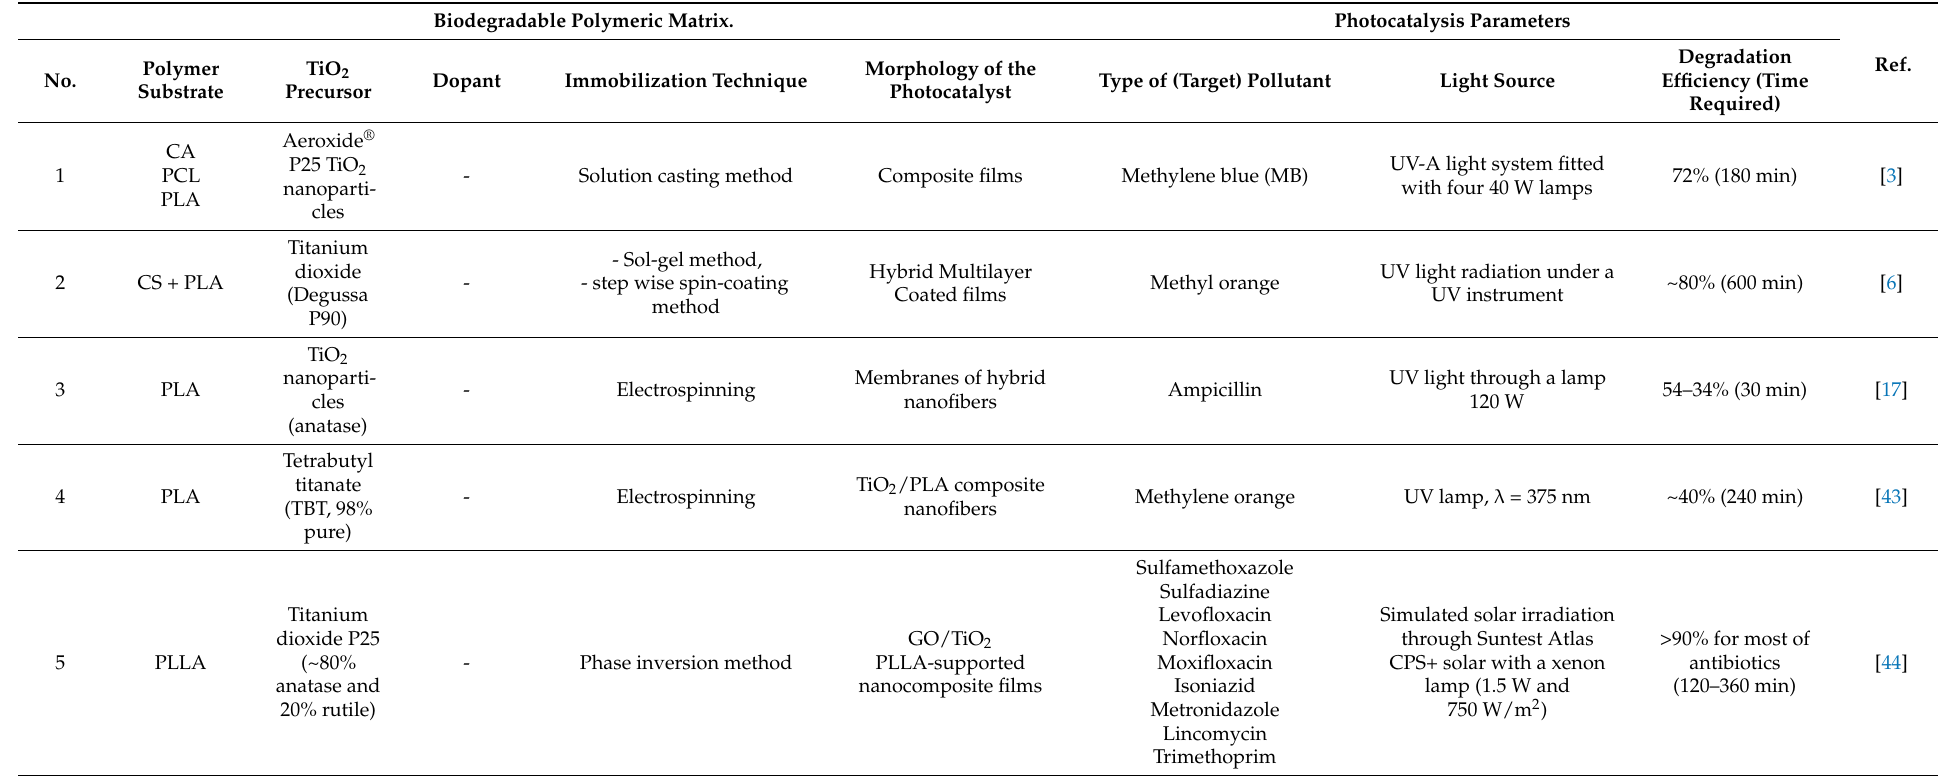
Table 4. Summary of the PLA-supported TiO 2 photocatalysts enclosed in the presented literature. Biodegradable Polymeric